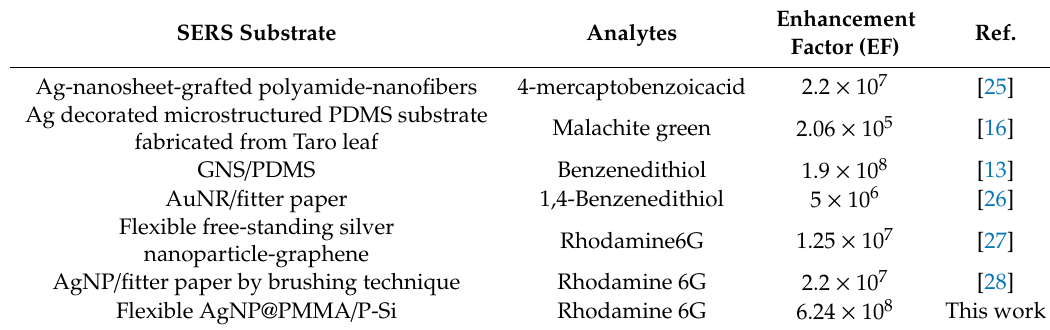
Table 1. Comparing the performance of various flexible SERS